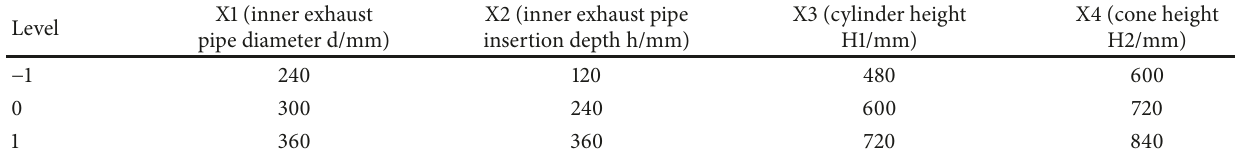
Table 4: Parameters